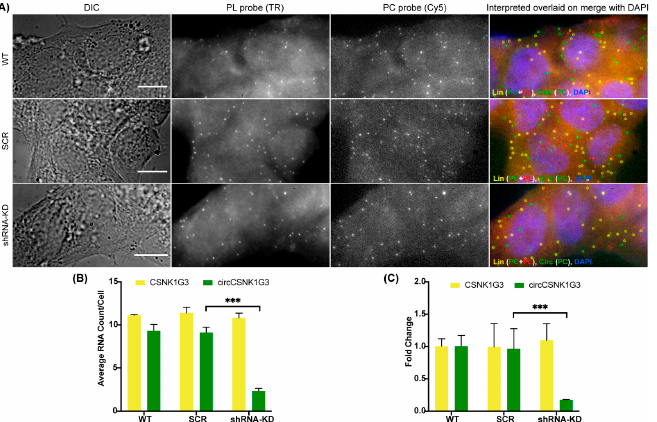
Figure 3. CircFISH after shRNA-mediated knockdown. ( A ) Representative image panel of wild-type (WT) DLD-1 cells (top), DLD-1 cells transduced with scrambled shRNA (SCR) (middle) or with shRNA targeting circCSNK1G3 (shRNA-KD) obtained using PL and PC probes for CSNK1G3. Columns from the left: DIC; raw merged z stacks of cells for PL probes labeled with TR; raw merged z stacks of cells for PC probes labeled with Cy5; a merged image of the two channels with TR spots pseudo-colored red and Cy5 pseudo-colored green, overlaid on DAPI, with MATLAB-interpreted spots showing the linear and circular RNAs as yellow and green spots, respectively. ( B ) Quantification of the CSNK1G3 and circCSNK1G3 signals after MATLAB analysis. The columns represent the average CSNK1G3 and circCSNK1G3 RNA molecules per DLD-1 cell, as analyzed in MATLAB. The error bars indicate the 95% confidence interval for at least 100 cells. ( C ) qRT-PCR data showing the fold change of CSNK1G3 and circCSNK1G3, normalized to Actin mRNA in DLD-1 -WT, SCR and shRNA-KD. The error bars indicate the standard deviation between triplicates. *** Indicates a significant difference with a p -value < 0.001. The scale bar is 5 µ m.